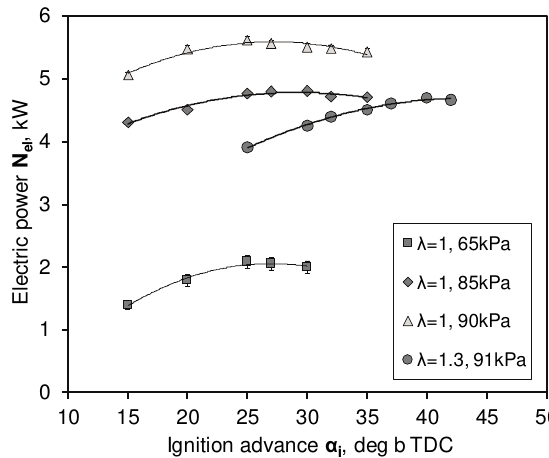
Fig. 2. Electric output power vs ignition timing, throttle position and mixture composition